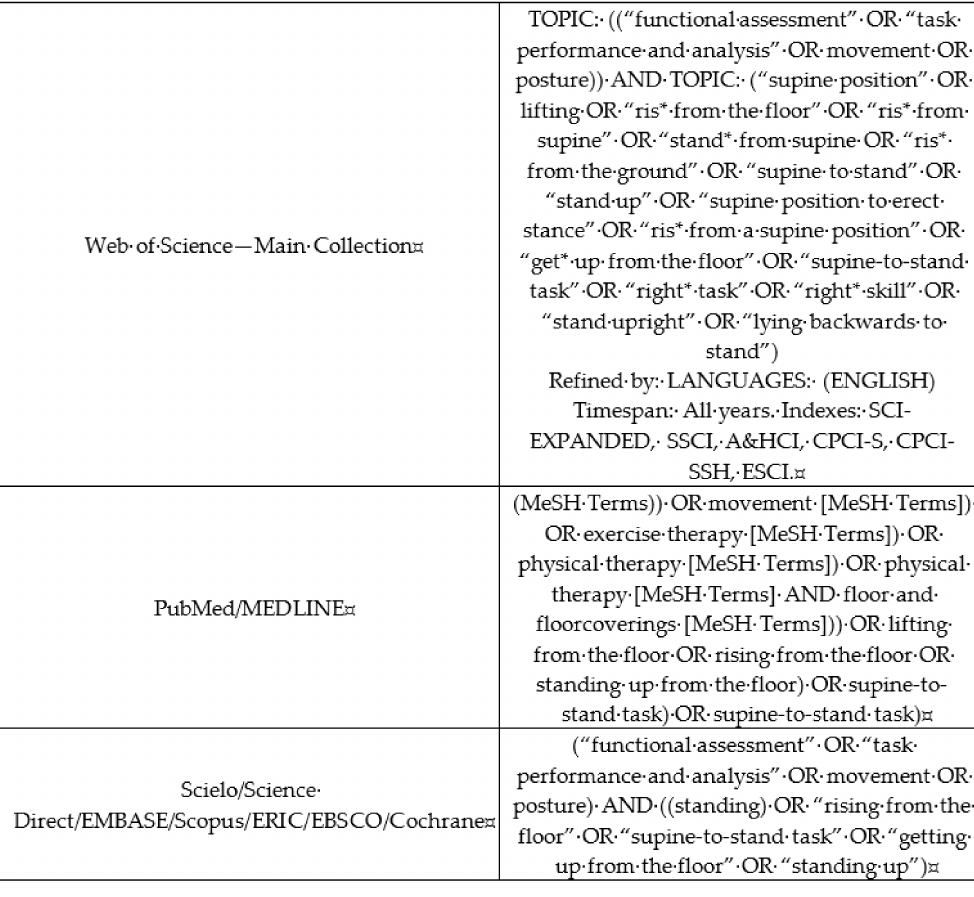
Figure 1. Descriptors used in the systematic review about the supine-to-stand (STS) task